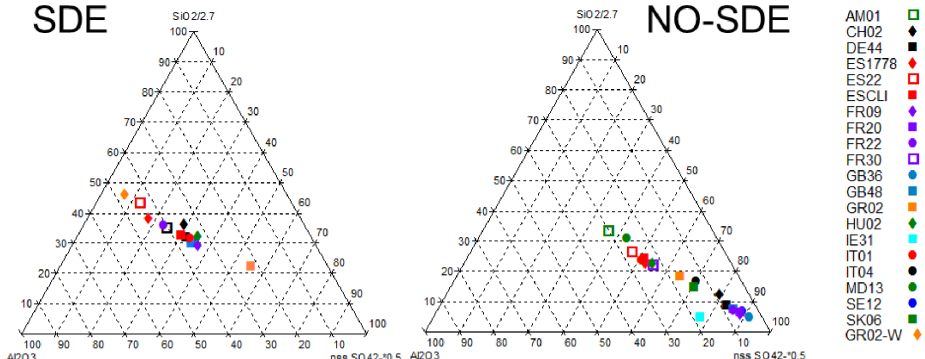
Figure 12. Ternary diagram for major mineral dust components (SiO 2 and Al 2 O 3 ) and SO 2 − SDE (right, NO-SDE). Orange: GR02; red: south-western and central southern Europe sites; purple: central western Europe; black: central Europe sites; blue; northern Europe and Atlantic sites; green: eastern Europe sites; empty symbols: high altitude